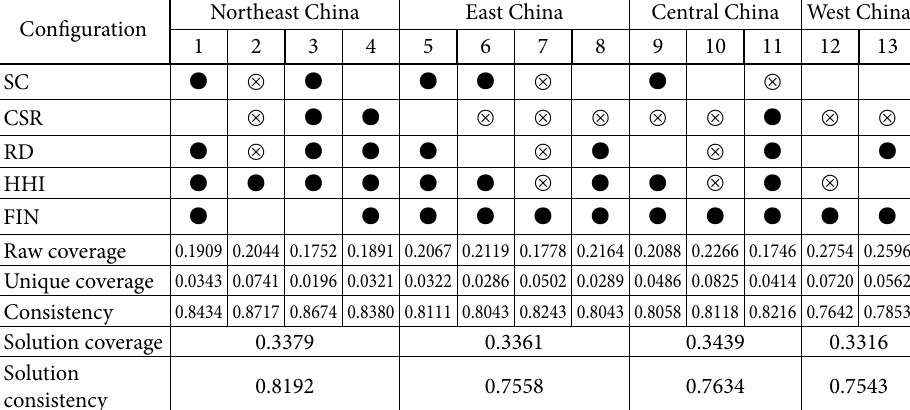
Table 6. Configurations leading to high-level risk-taking of regional corporates